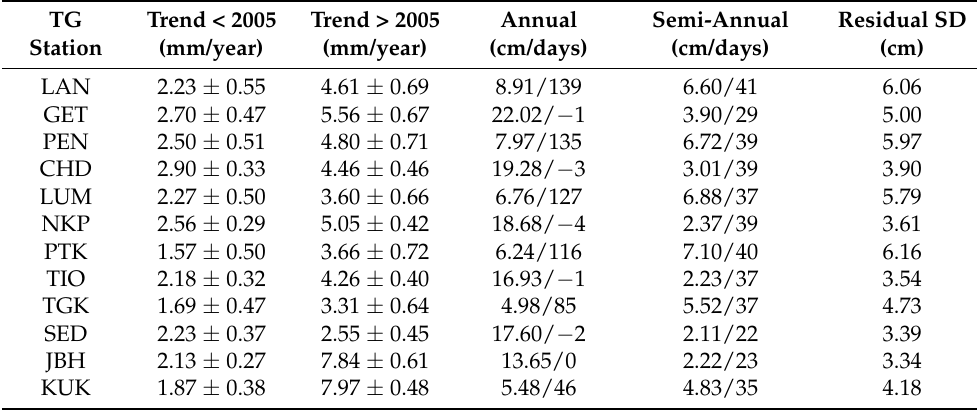
Table 2. TG results for peninsular tide gauges (Peninsular Malaysia), before and after 2005. For the periodic cycles, the amplitude and phase are given where the latter is transformed to days after 1 January. The residual sigma is the std of the difference between data and model fit. Trend uncertainties are given at a 95% confidence level (1.96 sigma).